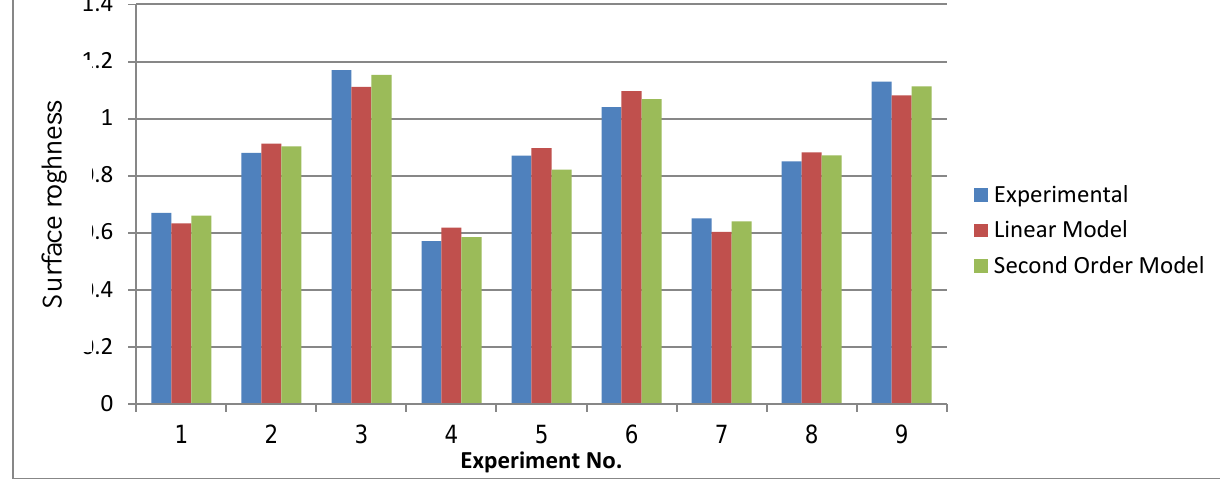
Fig. 4. Comparison of Experimental and Predicted values for Surface Roughness